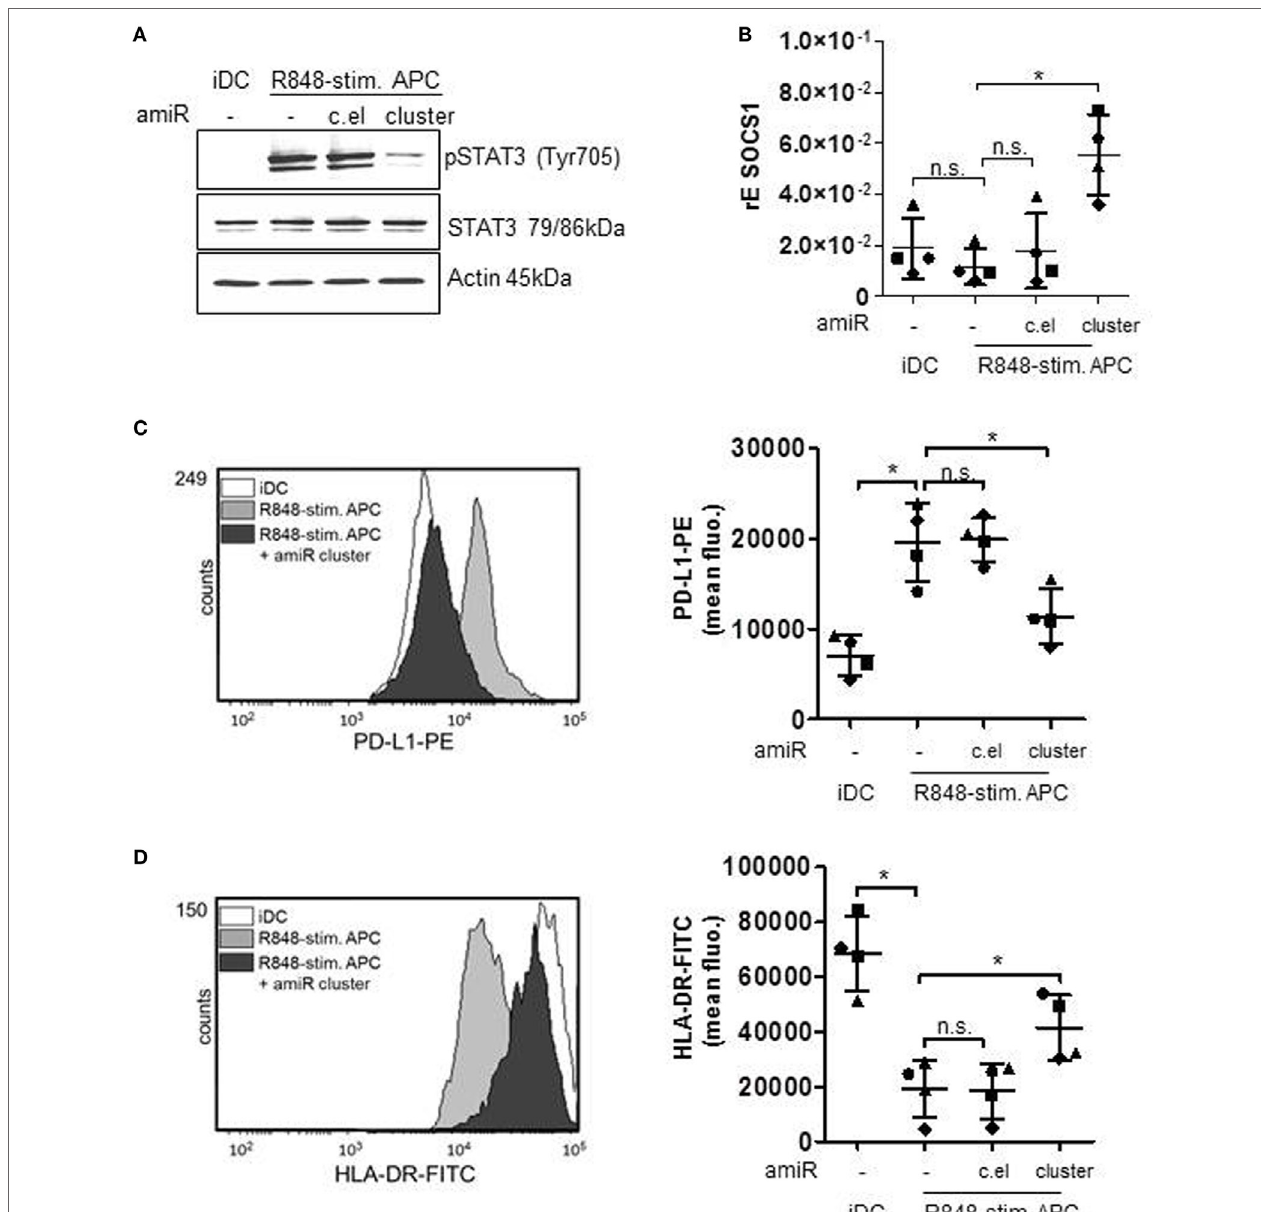
FigUre 4 | Monocytes were either treated with antagomiR (amiR) mix against miR-99b, let-7e, and miR-125a cluster (amiR cluster), amiR against c.el or left untreated. The next day cells were differentiated for 72 h into immature DCs (iDCs) (GM-CSF/IL-4) or R848-stim.APCs (GM-CSF/IL-4/R848). (a) Lysates were produced and applied for Western blot analyses for the detection of phosphorylated and total signal transducer and activator of transcription (STAT) 3. Actin was detected as loading control. Shown is one blot as representative example out of three. (B) RNA was isolated, cDNA produced, and qRT PCRs performed to analyze mRNA levels of suppressor of cytokine signaling-1 (SOCS1). (c,D) Cells were stained with specific antibodies against programmed death-ligand 1 (PD-L1) (c) or HLA-DR (D) and analyzed by flow cytometry. Overlays were produced by WEASEL software. Associated quantification displays four donors with mean and SD. Statistics: * p ≤ 0.05 by Mann–Whitney U